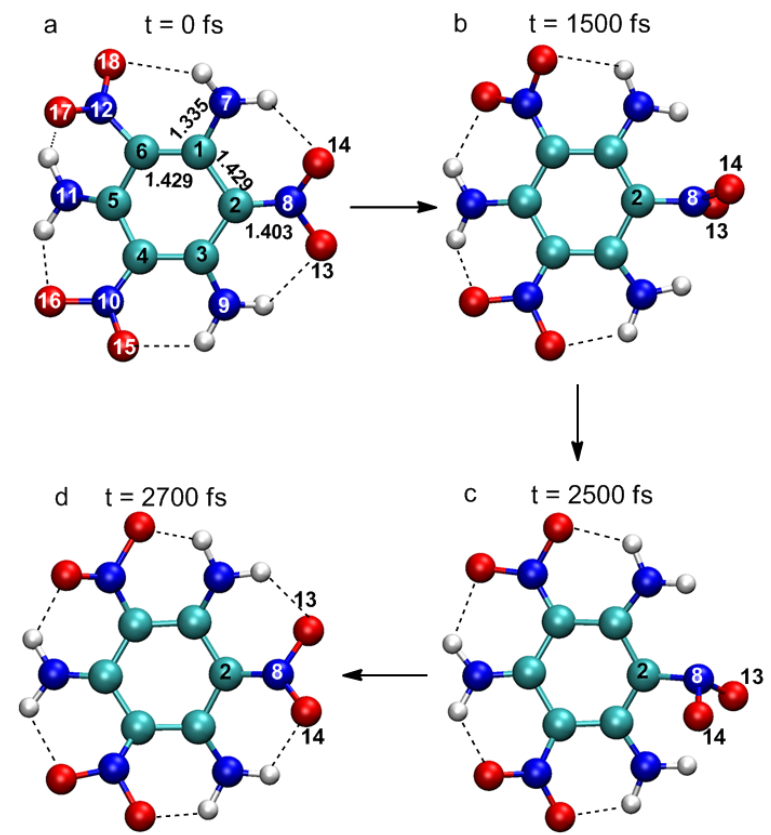
Figure 1. Snapshots for the deactivation of the excited state of the 1,3,5 ‐ triamino ‐ 2,4,6 ‐ trinitrobenzene (TATB) molecule following irradiation with a laser pulse of 3.2 eV photon energy and fluence of 32.94 J ∙ m − 2 . Cyan: C, blue: N, red: O, white: H.